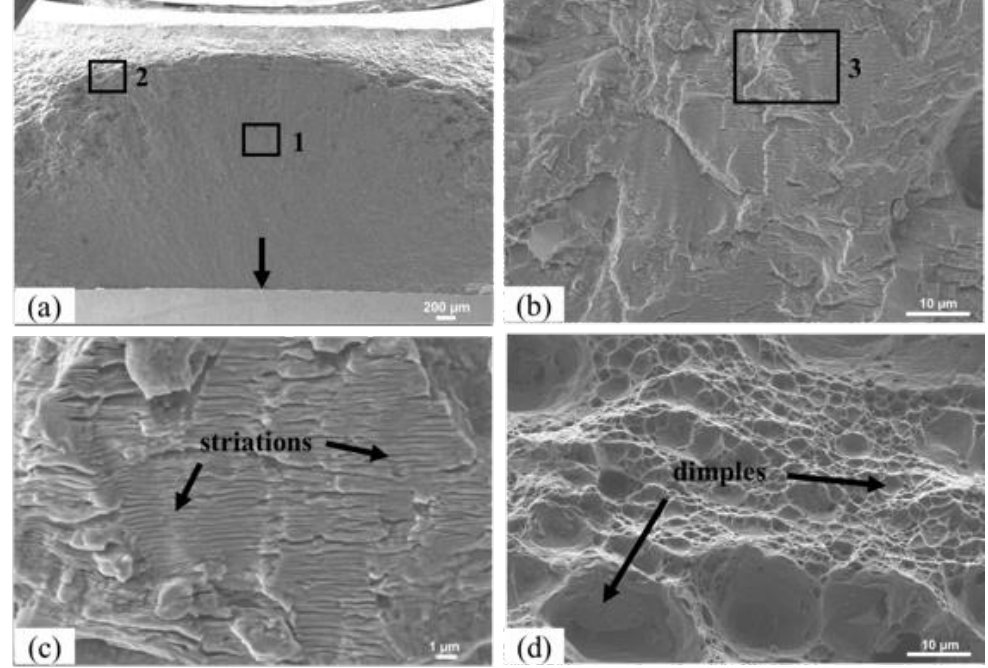
Figure 16. Fracture surfaces of a sample from the 562-30 series: ( a ) general fracture surface, ( b ) detail from location 1, ( c ) detail from location 3, and ( d ) detail from location 2.